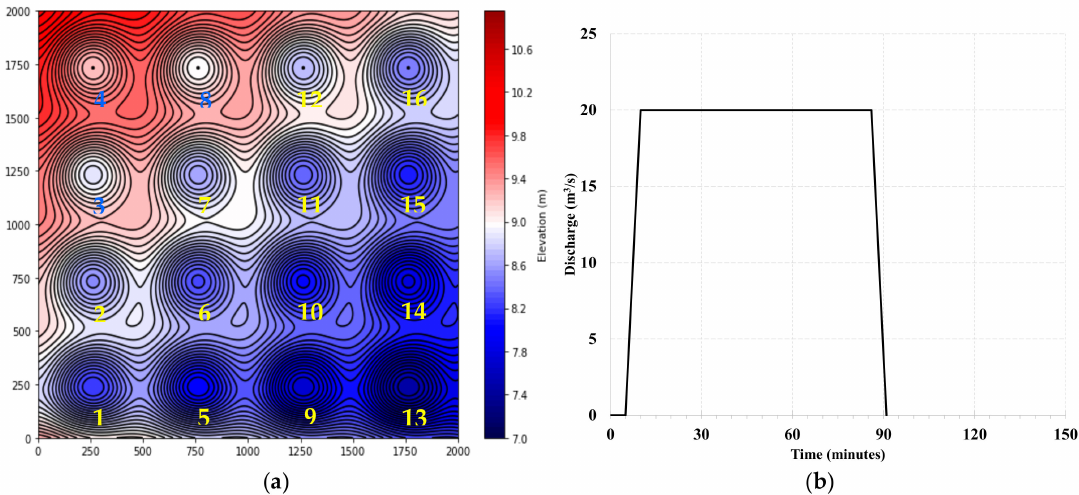
Figure 5. ( a ) EAT2 domain with contour lines every 0.05 m ( b ) Inflow from the northwest point (x, y = 0 m, 2000